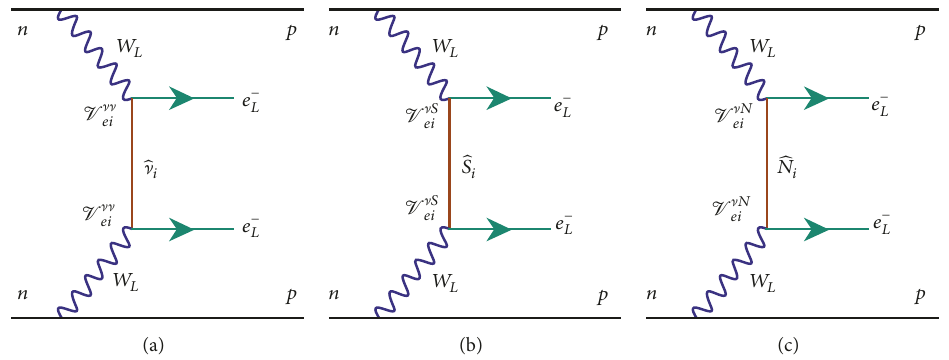
Figure 3: Feynman diagrams representing neutrinoless double beta decay due to exchanges of all three types of Majorana fermions ] , 𝑆 , and 𝑁 .